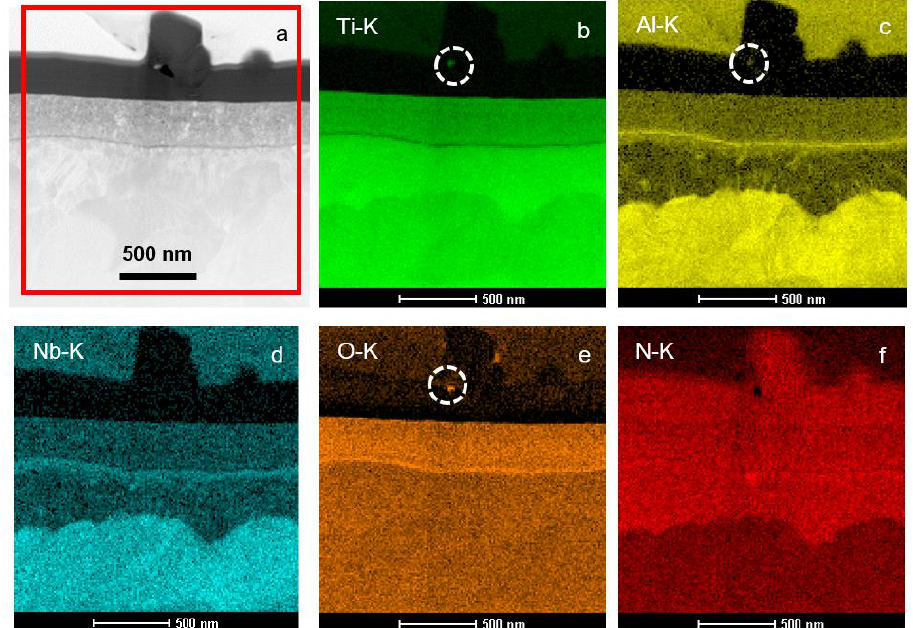
Figure 3. STEM/HAADF image of cross-section microstructure of surface TiN layer with frag- ments of twisted nano-whisker over it formed on PN and C coated Ti-6Al-7Nb alloy ( a ) as well as accompanying maps presenting distribution of Ti, Al, Nb, N and O ( b – f ) elements.